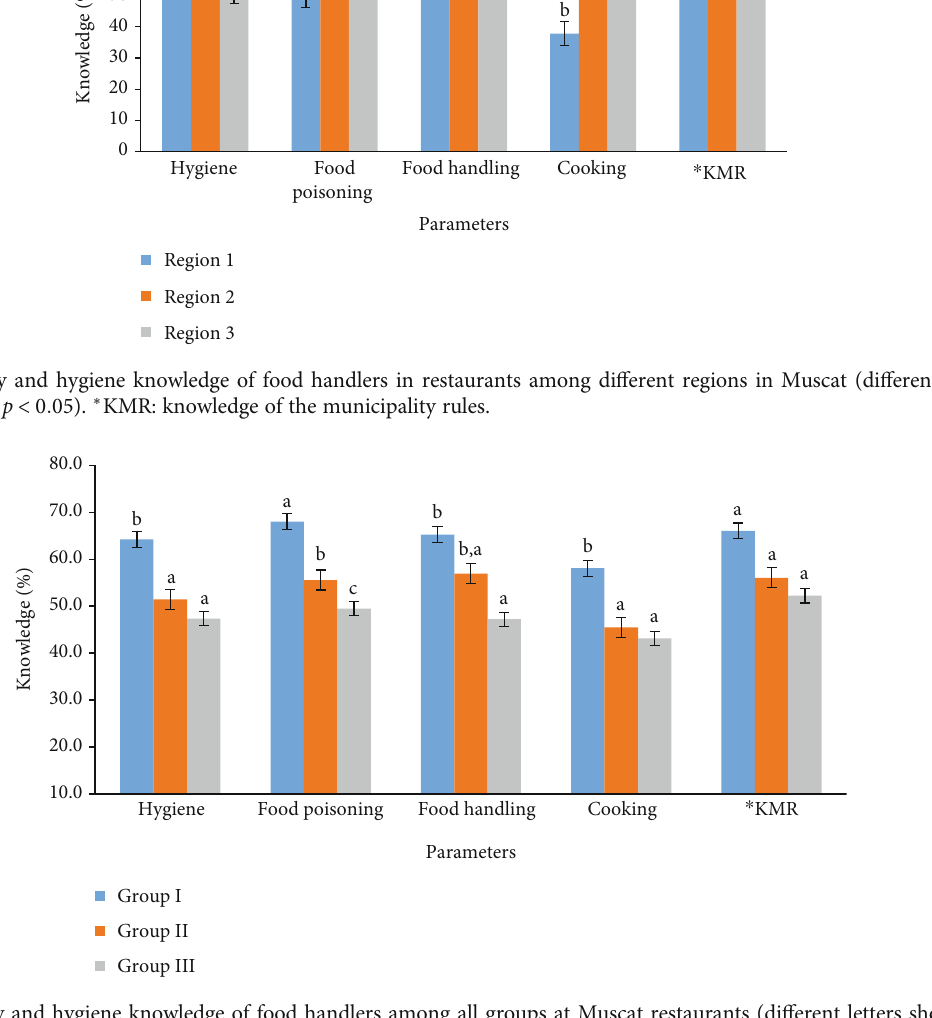
Figure 2: Food safety and hygiene knowledge of food handlers among all groups at Muscat restaurants (di ff erent letters show signi fi cant di ff erence, p < 0 : 05 ). ∗ KMR: knowledge of the municipality rules. Table 3: Microbial quality in restaurants among regions based on Total Aerobic Bacterial Count (log cfu/cm 2 ).